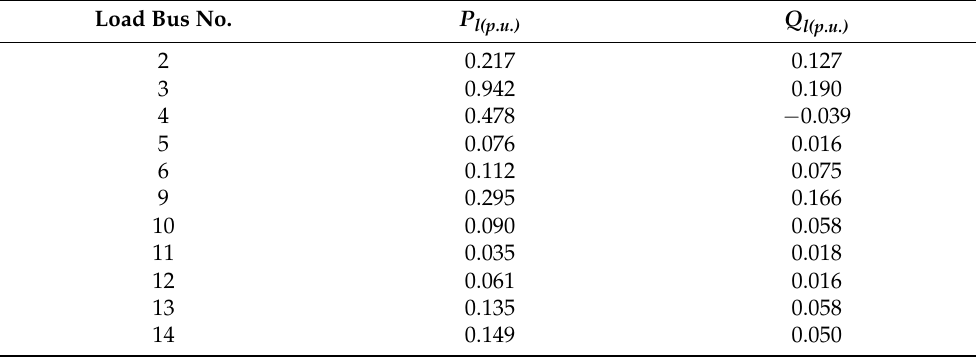
Table 7. System load configuration.